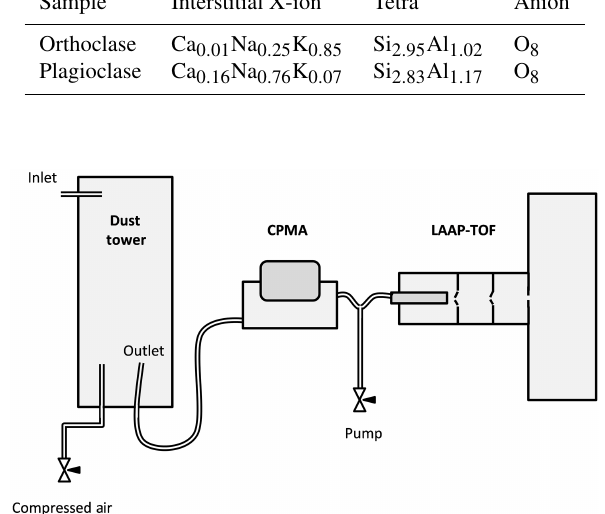
Figure 1. Schematic representation of the experimental set-up.